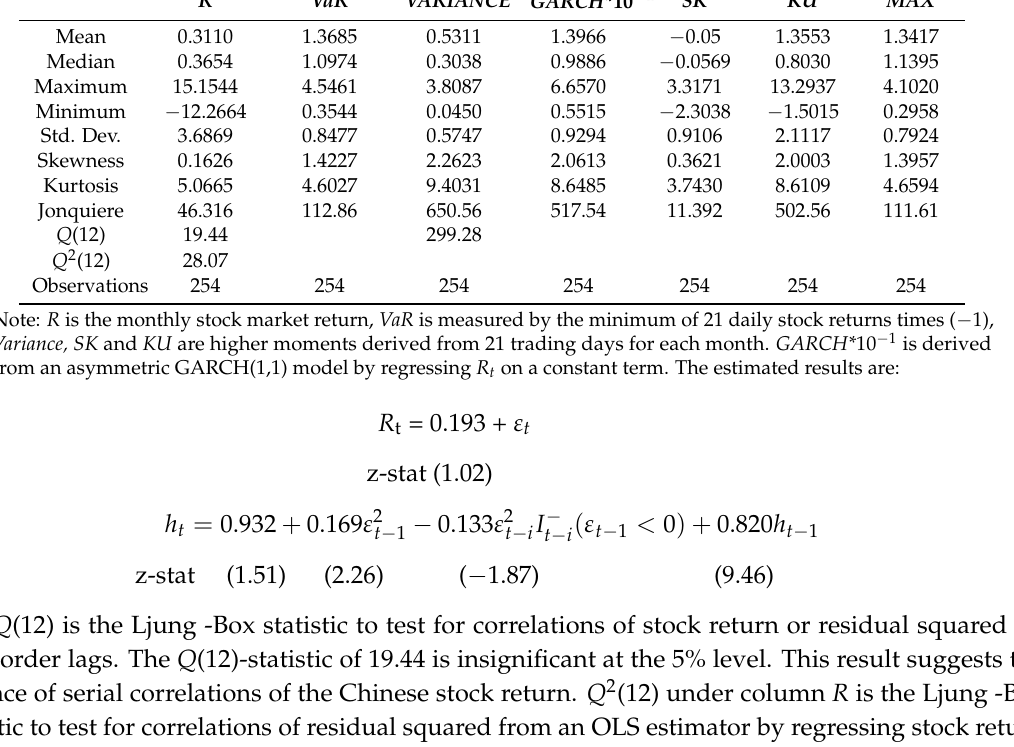
Table 1. Summary statistics of market returns, variance, skewness and kurtosis in Chinese markets.